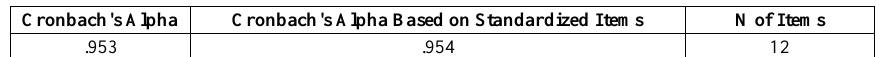
Table 4. Reliability